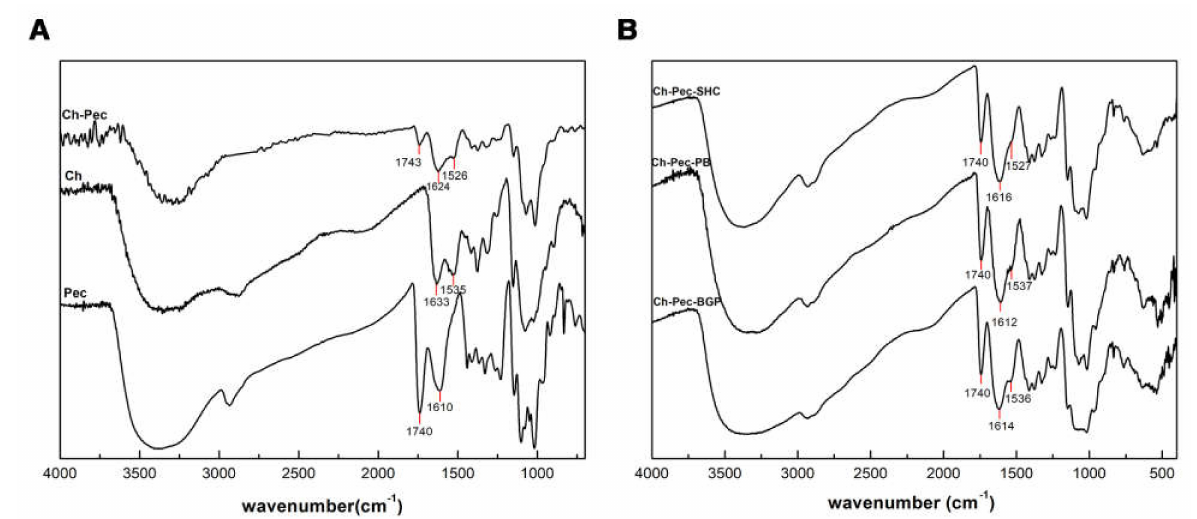
Figure 3. IR spectra of Ch, Pec and Ch–Pec mixing ( A ). IR spectra of Ch–Pec mixing with salts ( β GP, PB and SHC) ( B